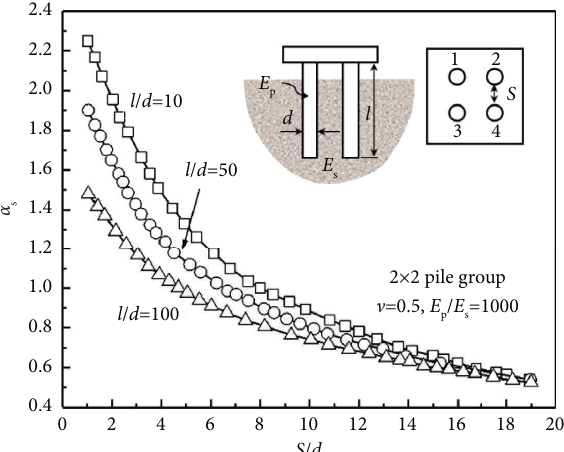
Figure 11: Efect of piles pacing for settlement on interaction factors of 2 × 2 group piles.